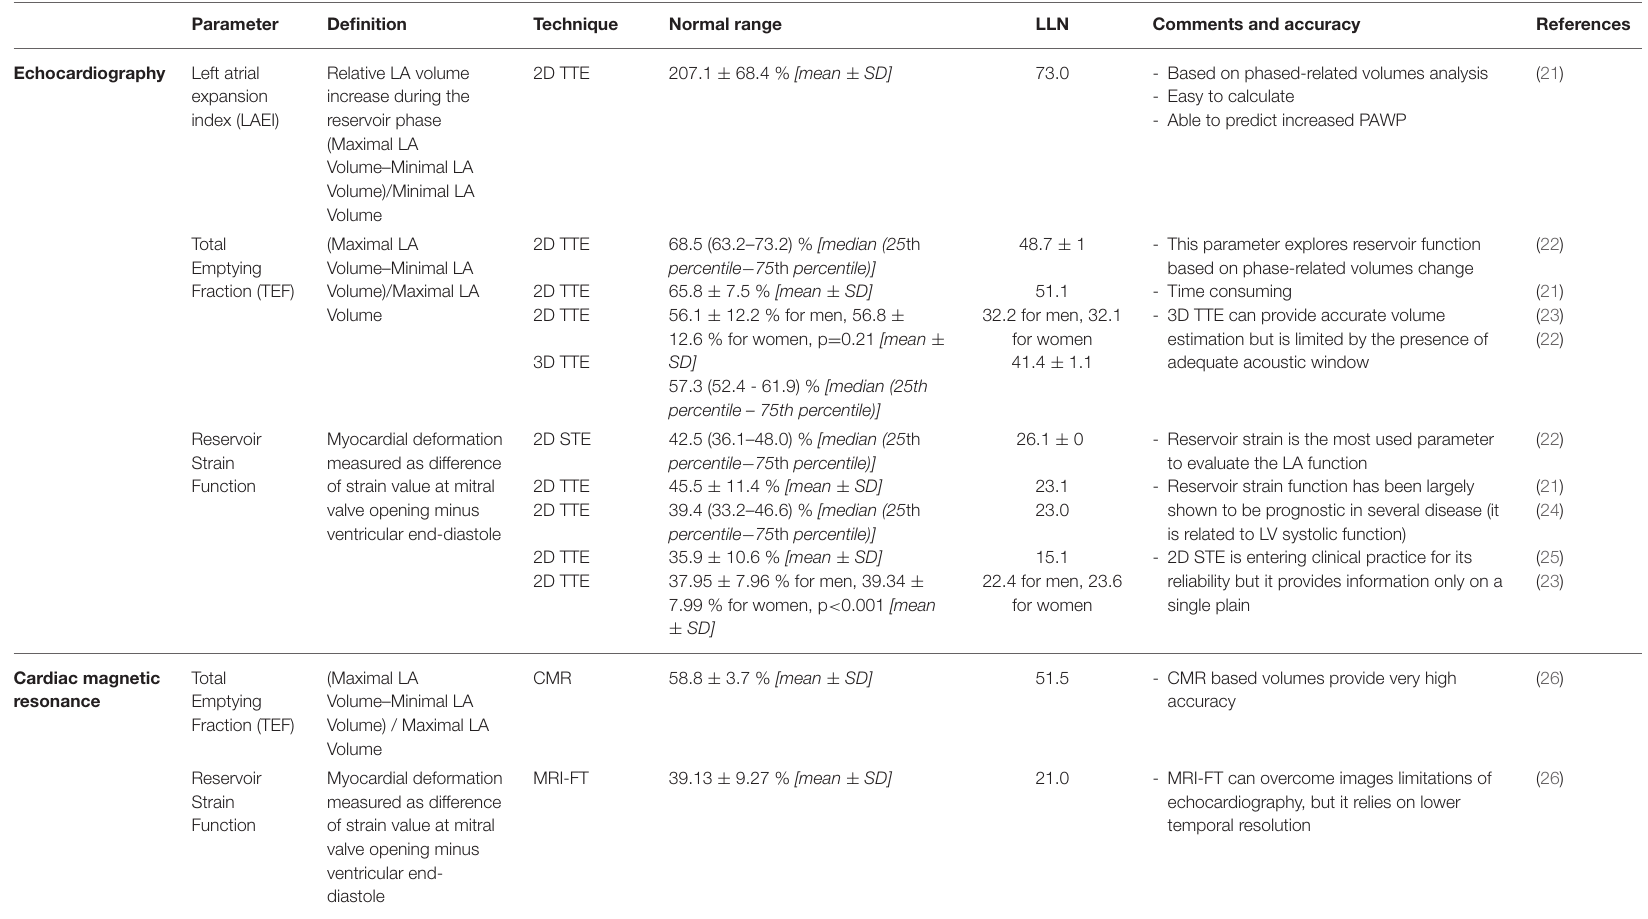
TABLE 1 | Most relevant parameters describing left atrium (LA) mechanics with reference values and lower limits of normality (LLN). Parameter Definition Technique Normal range